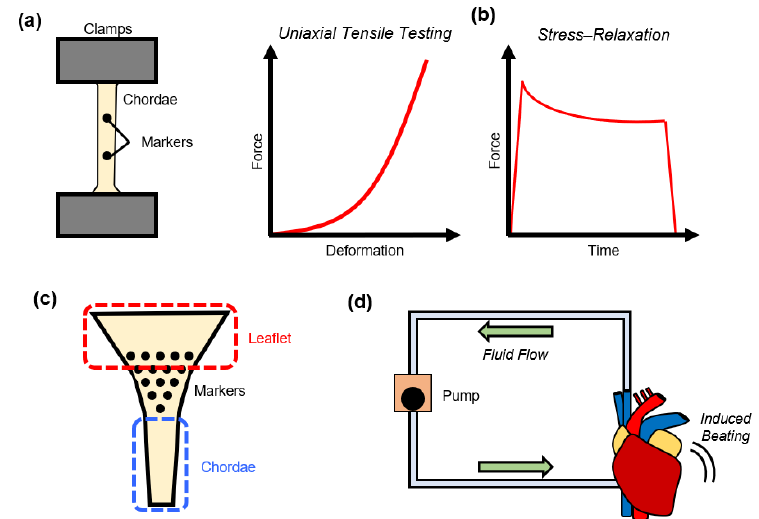
Figure 4. Mechanical characterizations of the atrioventricular heart valve (AHV) chordae tendineae through: ( a ) uniaxial mechanical testing, ( b ) stress-relaxation testing, ( c ) chordae-leaflet insertion region deformation tracking, and ( d ) an in vitro heart simulating flow loop.